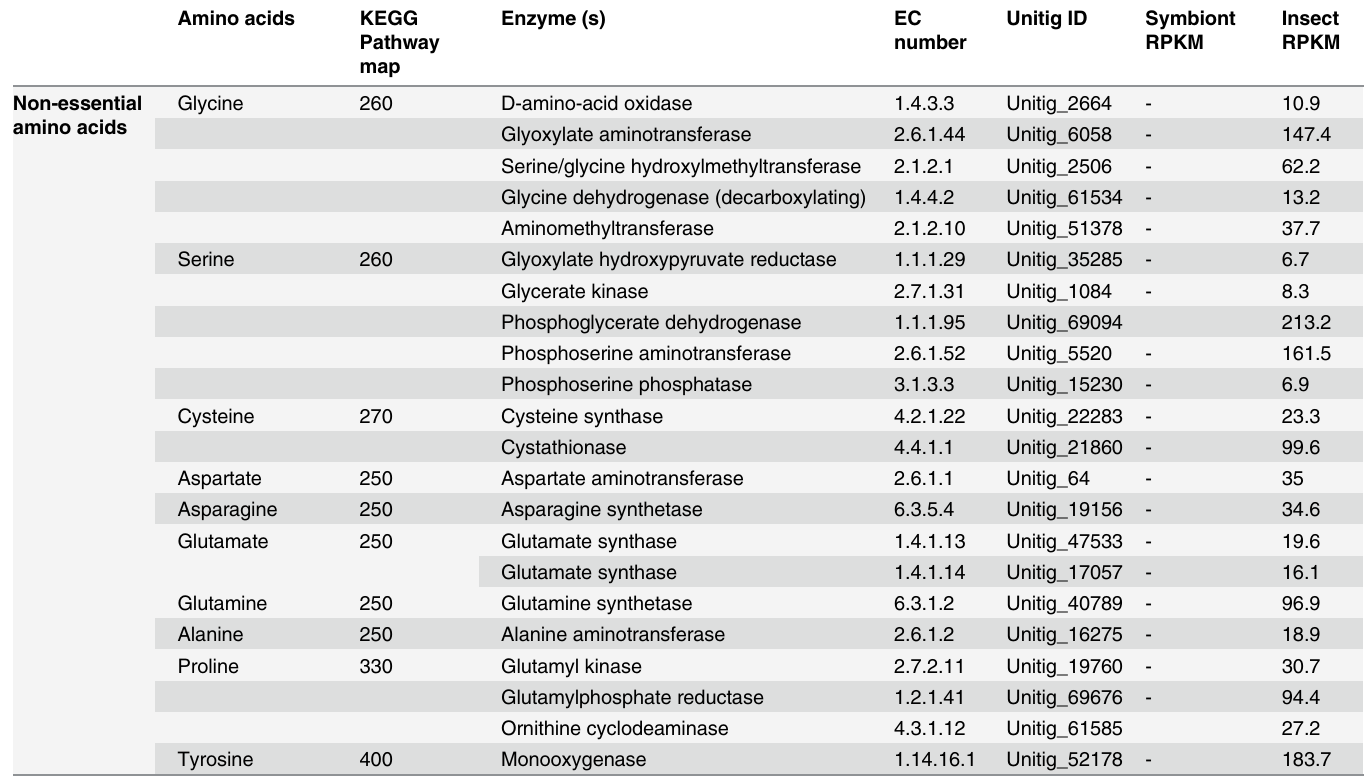
Table 2. The expression value (RPKM) of different genes involves in amino acid biosynthesis in the insect and the symbiont. Amino acids KEGG